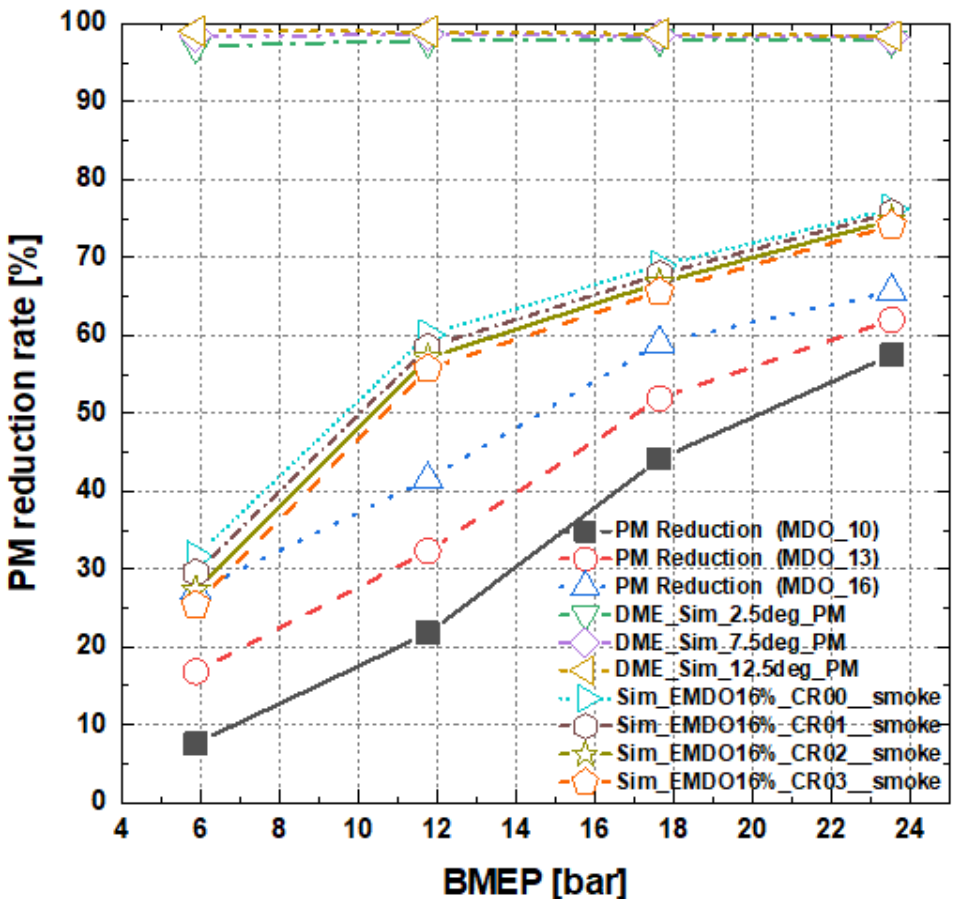
Figure 10. Particulate matter reduction rate according to MDO, EMDO, and DME fuels due to injection timing, turbocharger compression ratio, and moisture concentration.